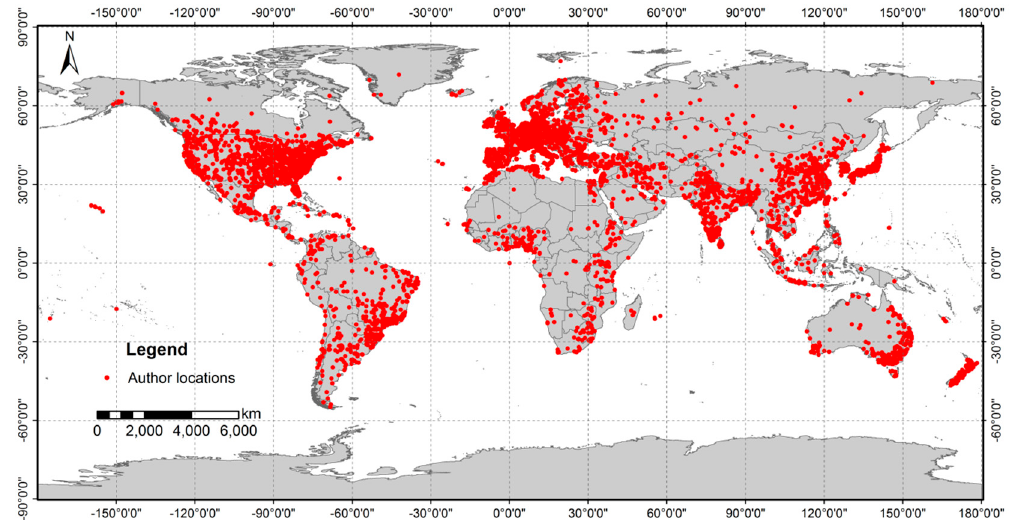
Figure 5. Global geographic distribution of authors in the field of SW research.